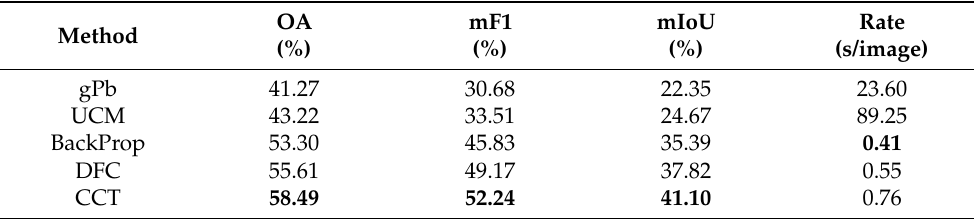
Table 3. Quantitative results of the comparative methods on Zhejiang dataset. The best values are in